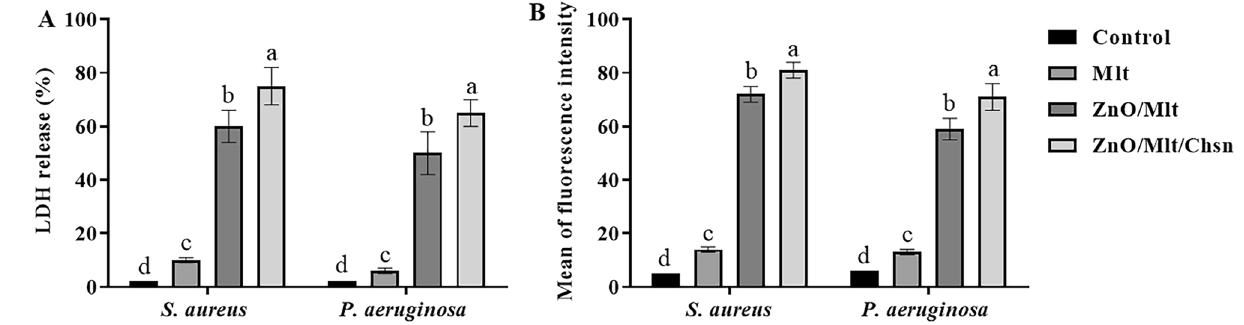
Figure 7. ( A ) Release of LDH (%) and ( B ) production of ROS of ZnO/Mlt/Chsn-NC nanocomposites on Staphylococcus aureus ( S. aureus ) and Pseudomonas aeruginosa (P. aeruginosa)